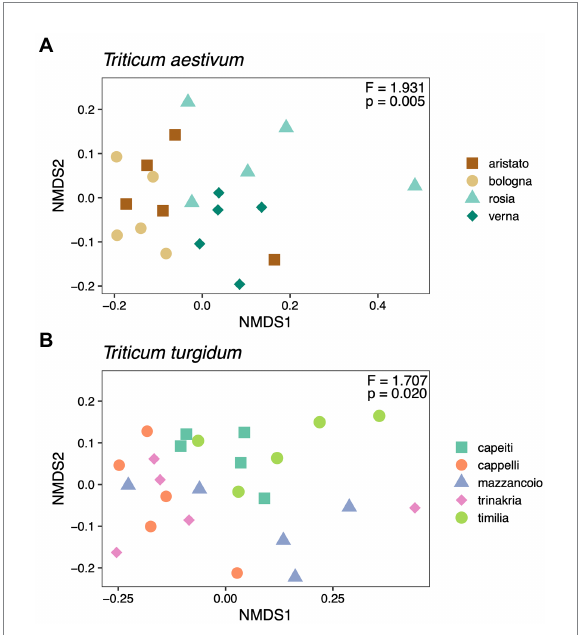
FIGURE 3 Non-metric Multidimensional Scaling (NMDS) ordination of cultivars within the Triticum aestivum (A) and Triticum turgidum (B) groups, calculated on a Unifrac distance matrix. Each panel shows also results from a PERMANOVA analysis (999 permutations, Unifrac distance matrix) testing the effect of cultivar within each